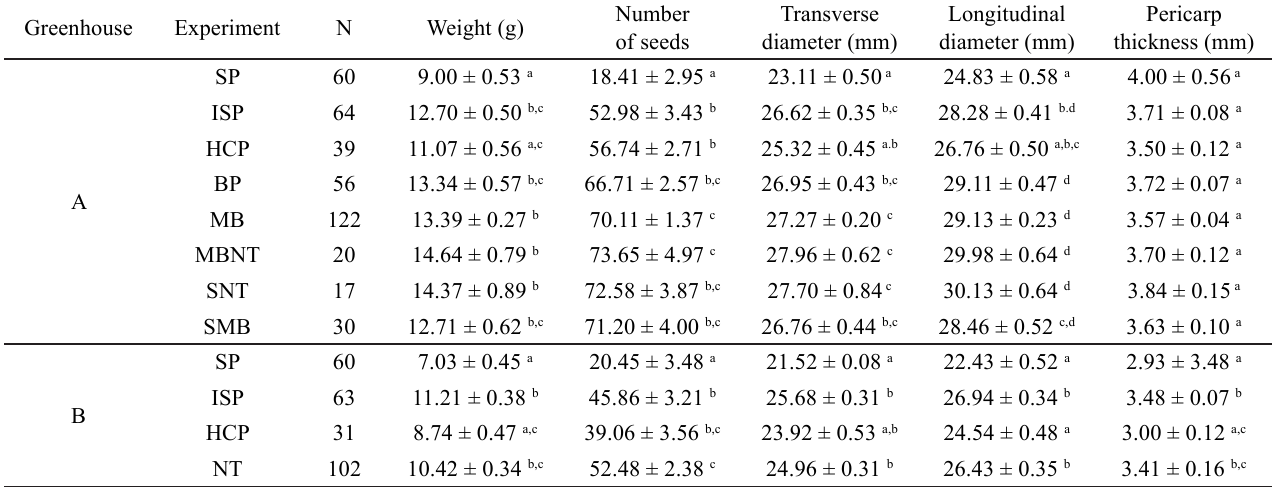
Table 1. Means followed by different letters (a-d) represent statistical differences (p <0.05) for the same attribute by the Kruskal-Wallis test and Dunn’s posterior